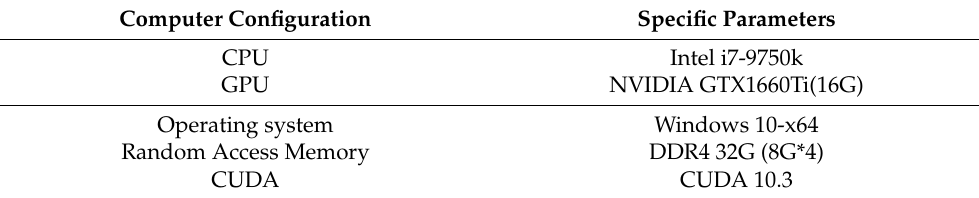
Table 2. Experimental